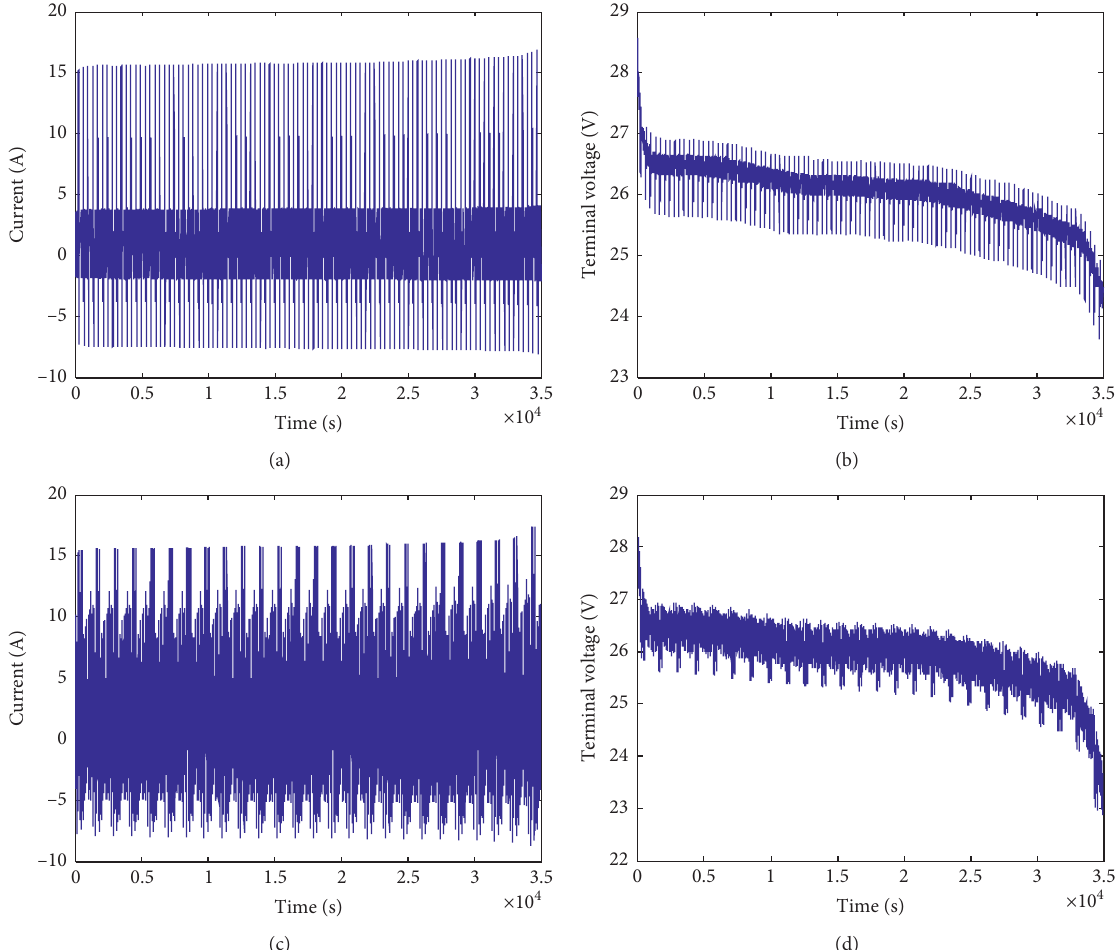
Figure 6: (a) Current under DST cycle. (b) Terminal voltage under DST cycle. (c) Current under FUDS cycle. (d) Terminal voltage under FUDS